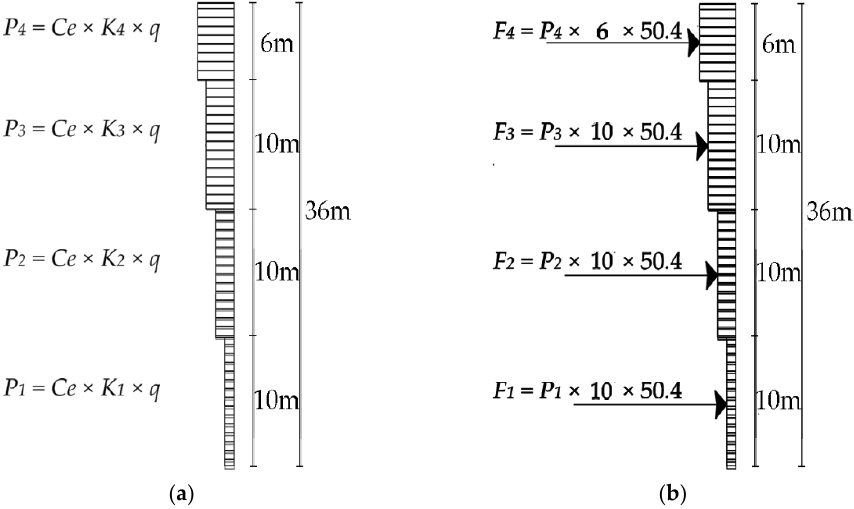
Figure 4. Applied wind pressures and forces on the building: ( a ) pressure distribution; ( b ) force distribution.